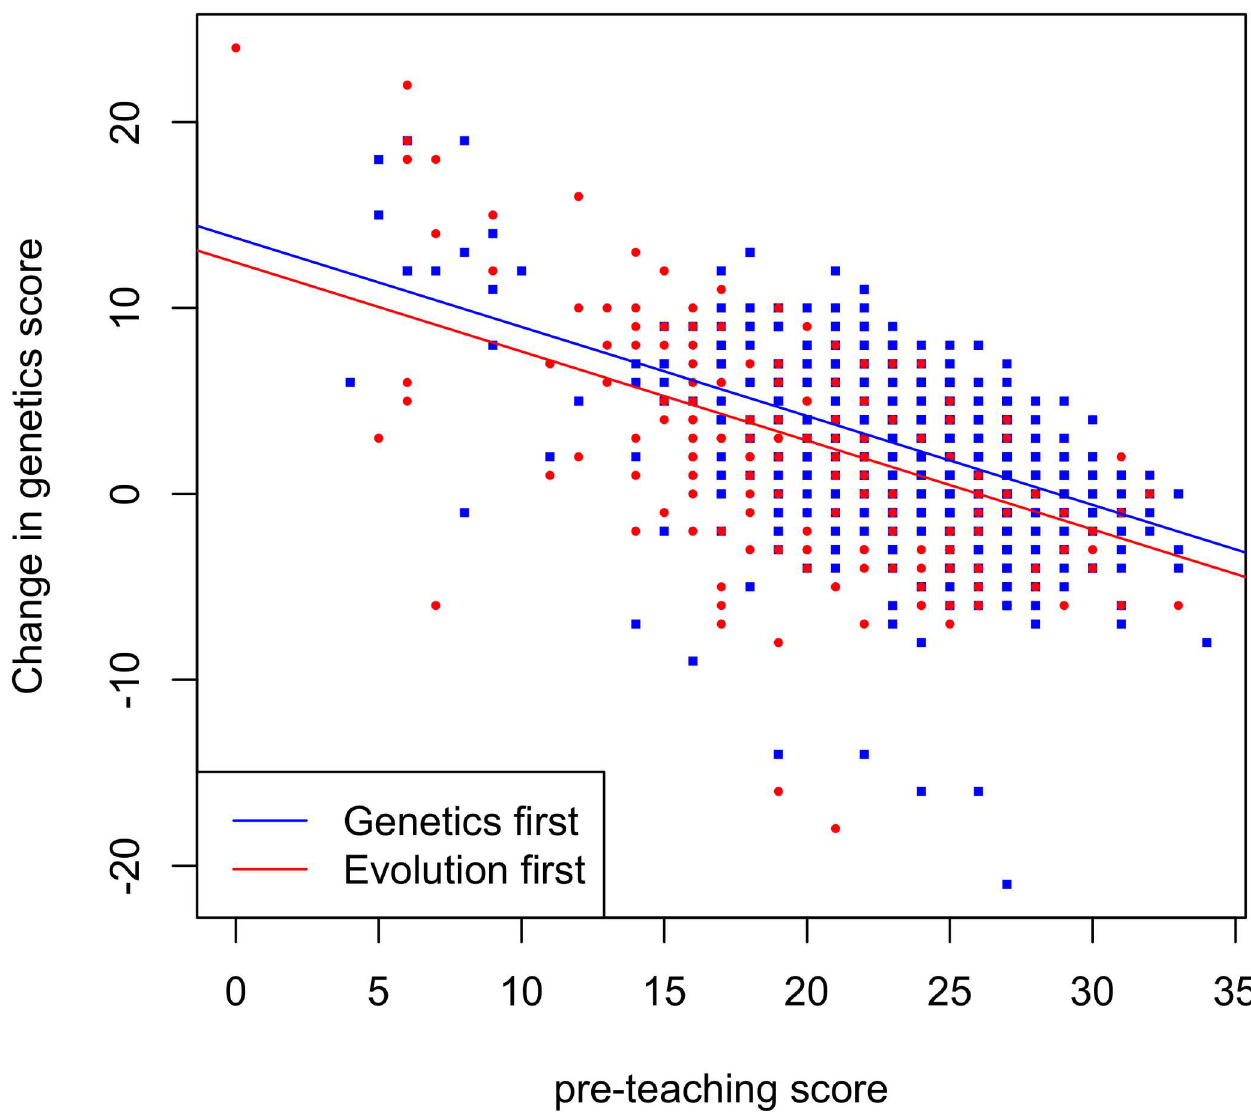
Fig 4. ANCOVA for change in understanding of genetics with preteaching score as a covariatefor different topic orders (genetics first: n = 776, evolution first: n = 451). Here, we employ the subset of 4 pupils who completedall pre- and all postquestionanaires.Raw data can be found in S1 and S2